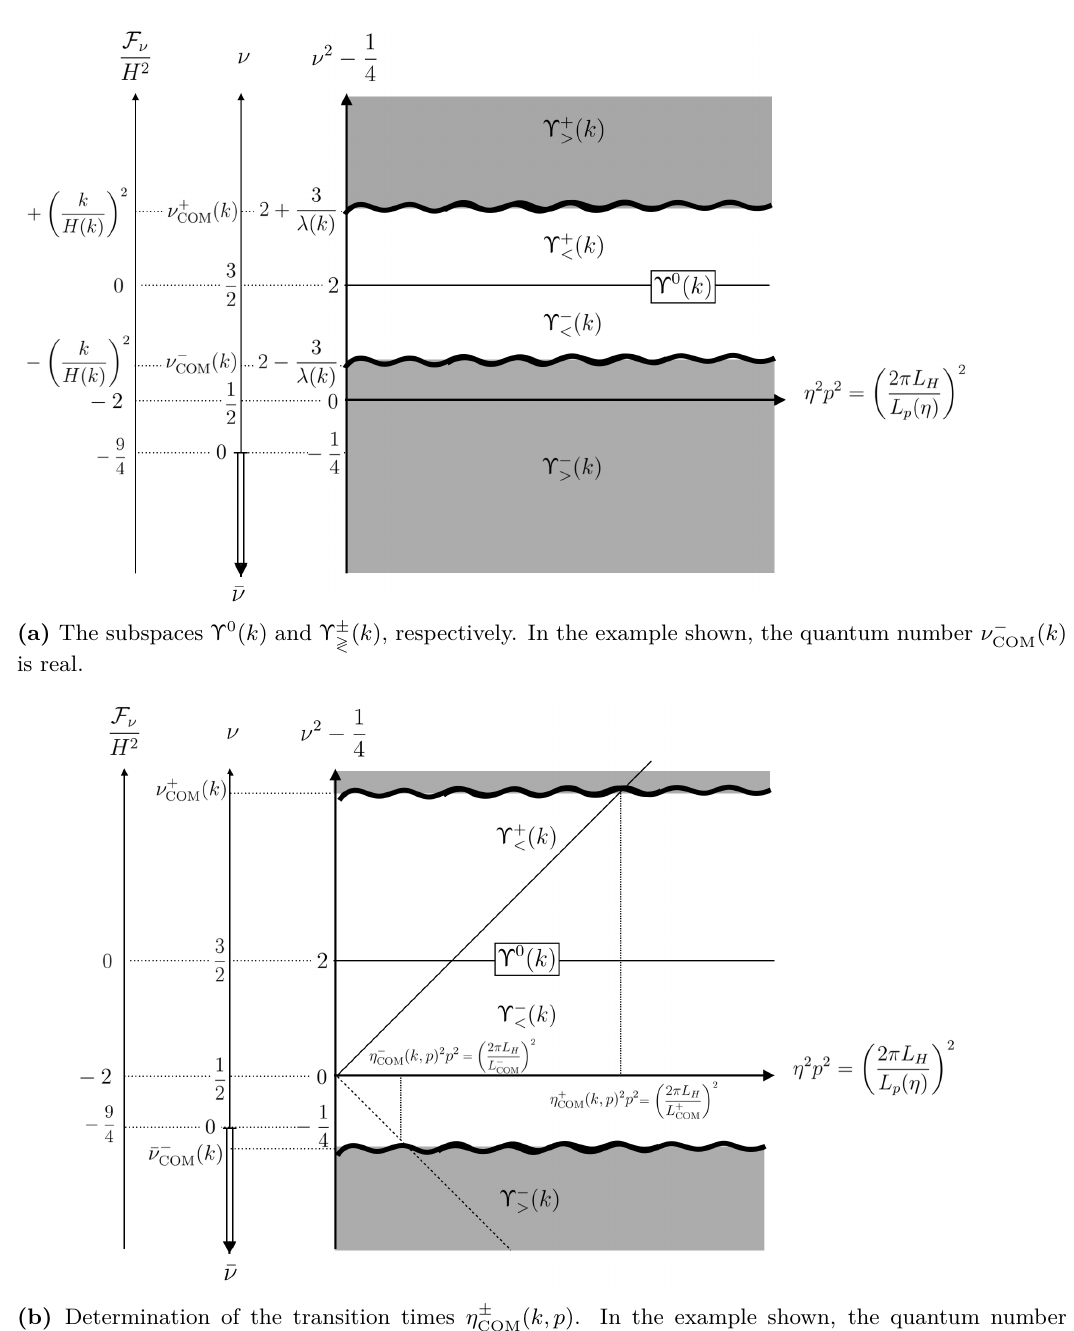
Figure 9. The space of eigenfunctions represented as in figure 3. For a specific scale k , the refined subsets of space- and timelike UV modes (cid:7) ± ( k ) are shown. The lightlike (cid:7) 0 modes correspond to ? the ν = 3 / 2 line. In the second diagram, spacelike (timelike) cutoff modes, indicated by the upper (lower) wiggly line, transit from the harmonic to the power (log-oscillating) regime at the conformal time η + ( η − COM COM